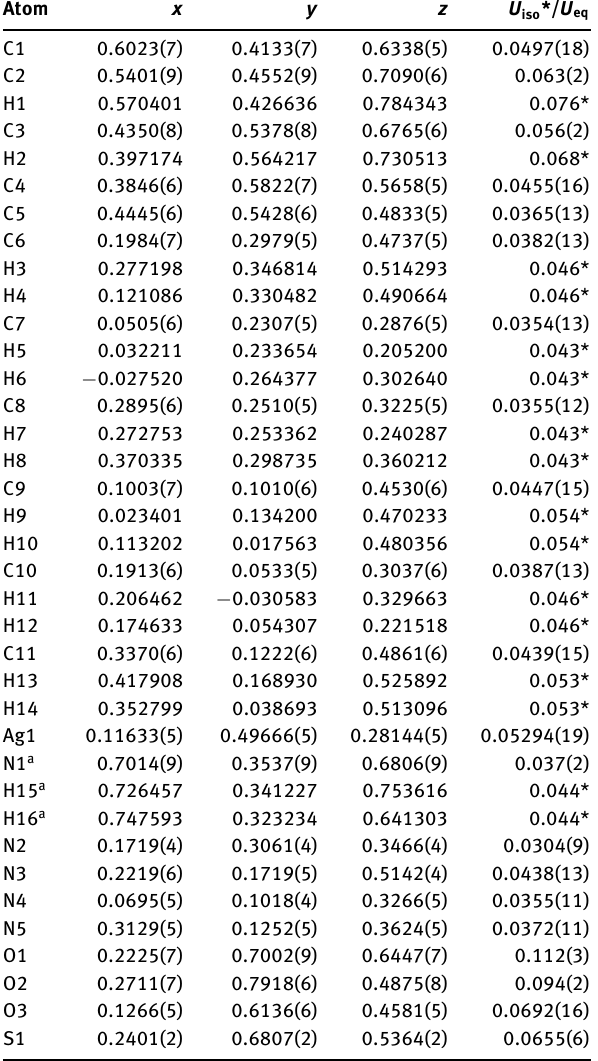
Table 2: Fractional atomic coordinates and isotropic or equivalent isotropic displacement parameters (Å 2